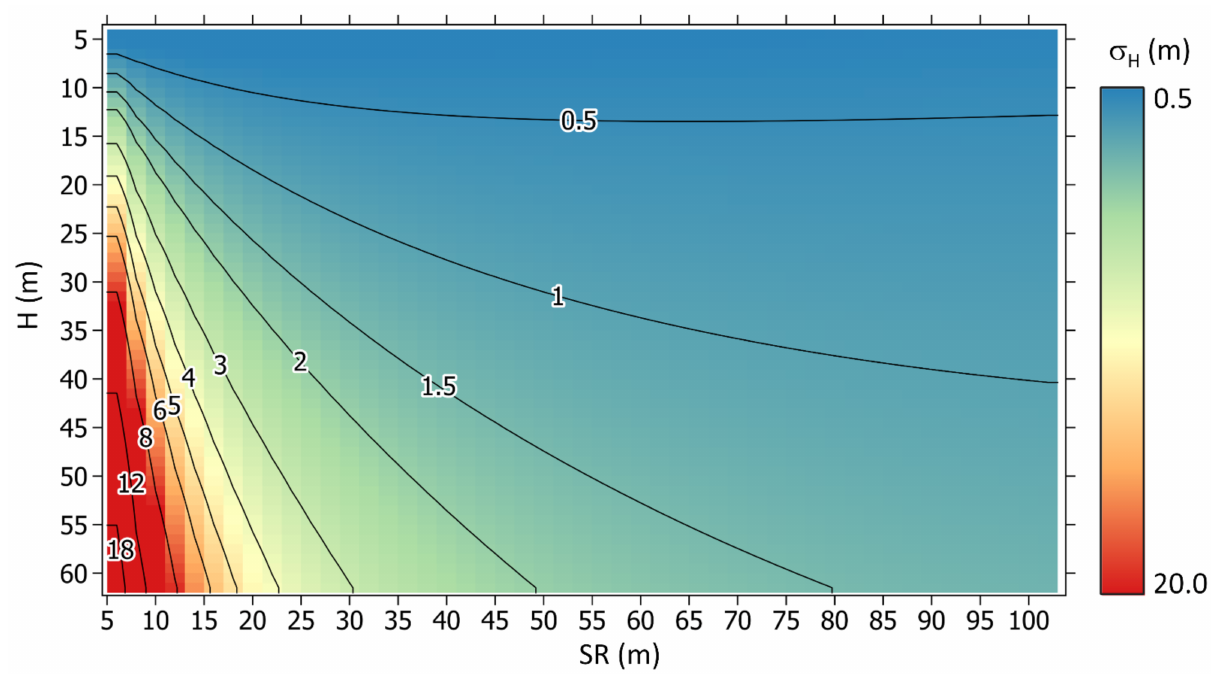
Figure 6. σ H scenarios ( ϕ = 15 ◦ ) obtained by all possible combination between H and SR . Isolines represent line having same σ H